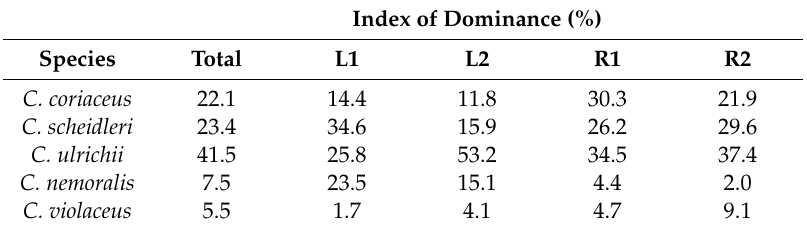
Table 2. The index of dominance calculated for Carabus species at four di ff erent forest stands (L1 and L2 are forest plots and R1 and R2 are recovering forest plots) at the locality of B á b (southwestern Slovakia) in